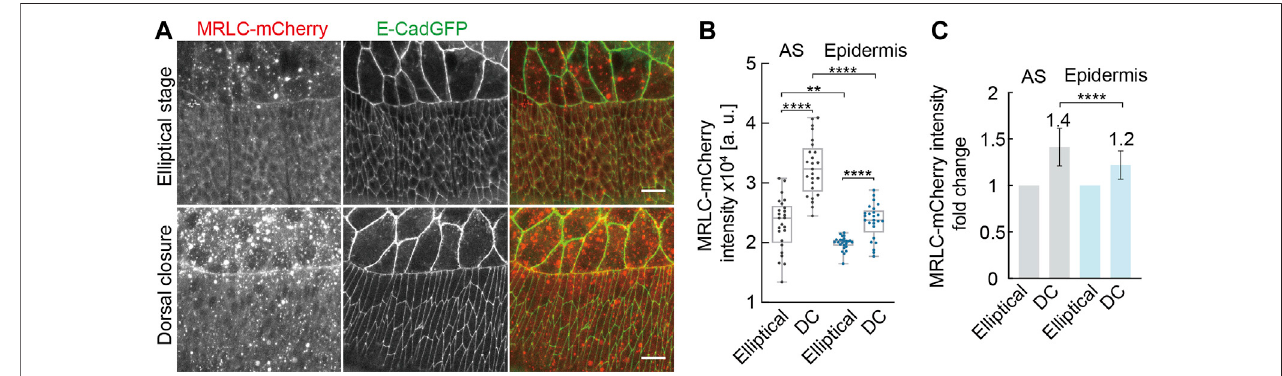
FIGURE 6 | Developmental up-regulation of non-muscle myosin II both in AS and in lateral epidermal cells during morphogenesis. (A) Maximum Z-projections of spaghetti squash (the regulatory light chain of the non-muscle myosin II in Drosophila ) visualized by MRLC-mCherry at the elliptical stage and during dorsal closure. E-CadGFPlabelsthecelloutline. (B) Quanti fi cationofMRLC-mCherryintensitiesinASandlateralepidermalcellsattheellipticalstage(Elliptical)andduringdorsalclosure (DC). For details, see Methods. Boxes, second and third quartiles; whiskers, the min to the max; horizontal line, median; dots, individual data. N = 25 from fi ve embryos, fi ve independent measurements from each embryo from each tissue in each stage. (C) Quanti fi cation of MRLC-mCherry intensities fold change in AS and lateral epidermal cells. MRLC-mCherry intensities from the elliptical stage embryos were normalized to 1. Two-way ANOVA estimates the p values, ** p < 0.01, **** p < 0.0001. Scale bars are 10 μ